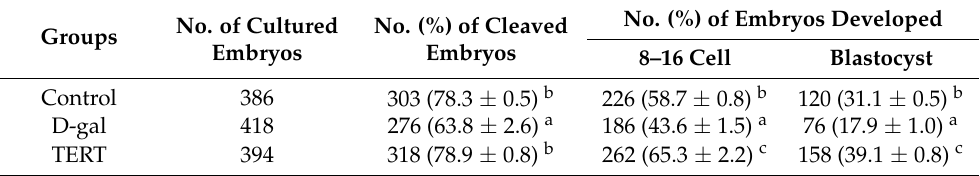
Table 1. In Vitro Development of Embryos Cloned Using Different Methods. Groups